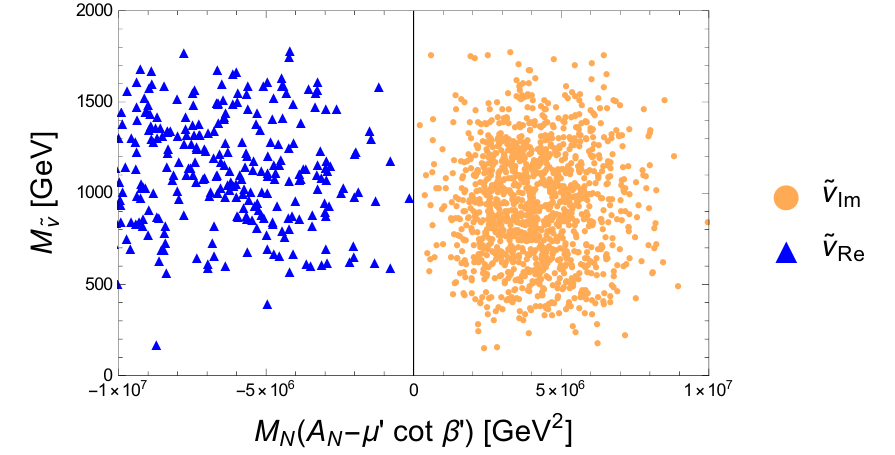
Figure 1 . Masses of real and imaginary RH sneutrino LSP candidates are plotted against the mass di(cid:11)erence of the two eigenstates, M N ( (cid:22) 0 cot (cid:12) 0 (cid:0) A N ). p at the LHC with s = 13 TeV and L = 40 fb (cid:0) 1 luminosity in ref. [50]. In doing so,